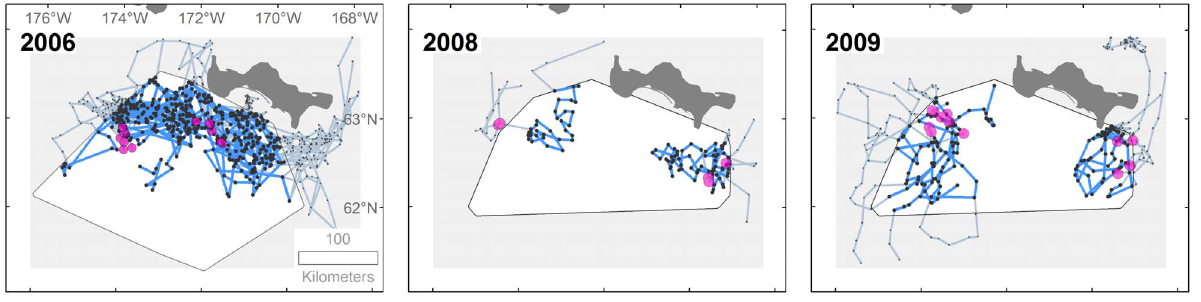
Figure 2. Pacific walrus radio-tracks within benthic sampling areas in 2006 and 2008–2009. Also indicated are radio-tag deployment locations (pink circles) and subsequent daily mean locations (black dots). Movements from the deployment location with durations greater than one day or outside of the benthic sampling area are represented by lighter-colored radio-tracks to provide a larger context of walrus movements.